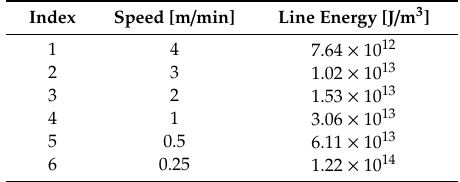
Table 2. Laser speed and line energy used in the experiment.